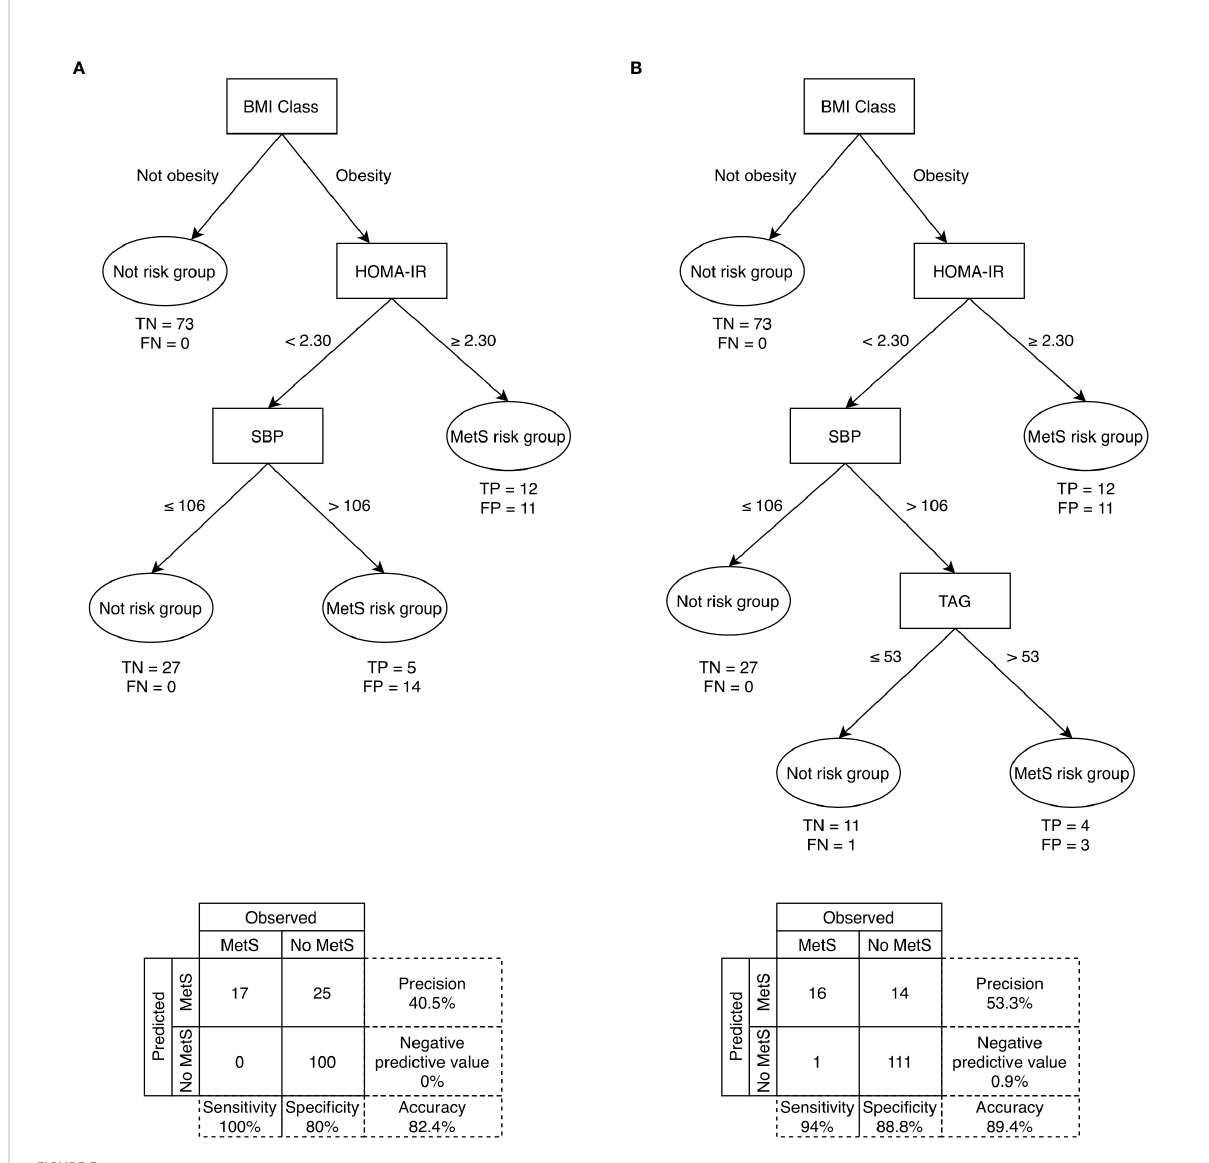
FIGURE 3 Fast-and-frugal decision trees for identifying prepubertal children in risk of developing MetS in puberty with sensitivity (A) 1.5 times and (B) 1.2 times more important than speci fi city. DBP= Diastolic blood pressure; FN, False negative; FP, False positive; HDL-c, High-Density Lipoprotein cholesterol; HOMA-IR= homeostasis model assessment of insulin resistance; MetS= Metabolic syndrome; SBP, Systolic blood pressure; TAG, Triacylglycerols; TN, True negative; TP, True positive. Sensitivity (i.e., correctly classifying individuals with MetS in puberty); speci fi city (i.e., correctly classifying individuals without MetS in